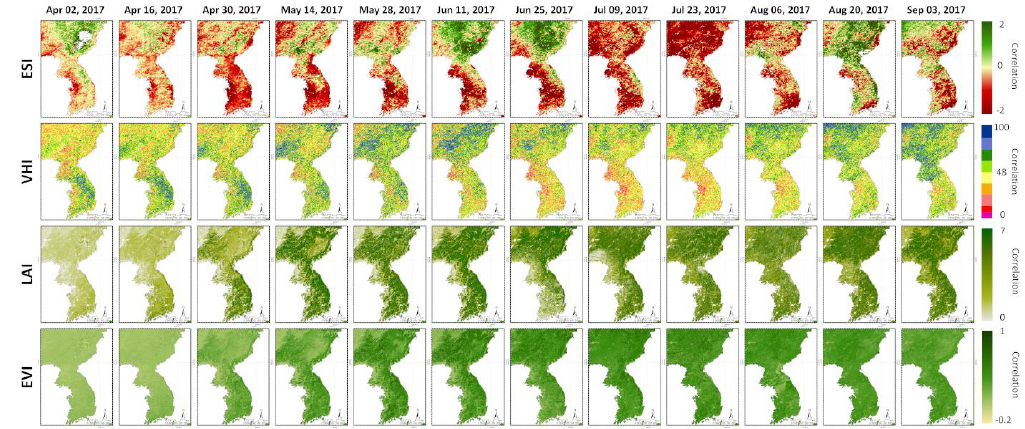
Figure 1. Comparison of trends for each drought index for South Korea and North Korea.